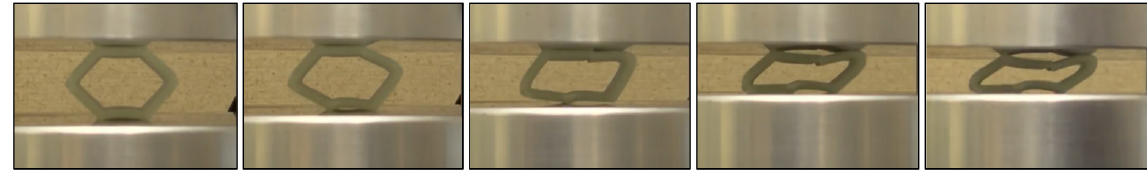
Figure 20. Experimental load vs. displacement curves for hexagonal cell under lateral load.